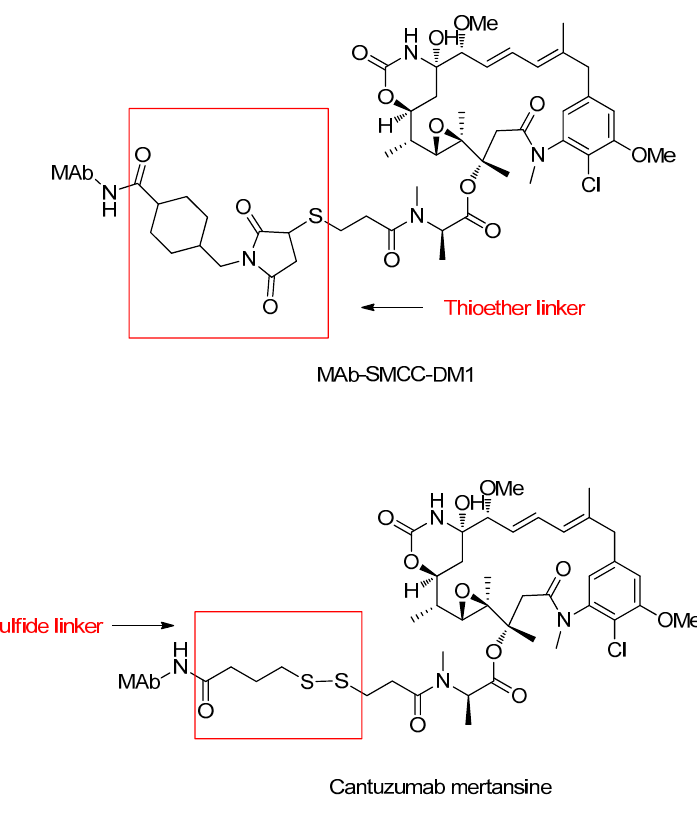
Figure 4. The structural formula of huC242-SMCC-DM1 and cantuzumab mertansine. Adapted from reference [47].